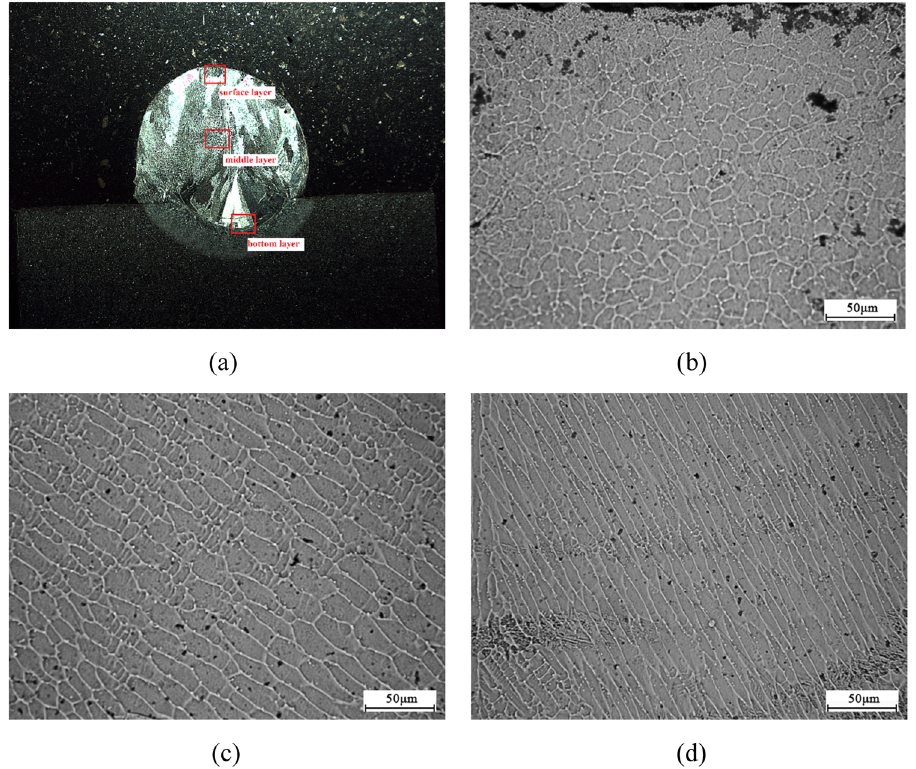
Figure 12: Microstructure of single - pass cladding layer on Observation surface #1: ( a ) macro image; ( b ) surface layer; ( c ) middle layer; and ( d ) bottom